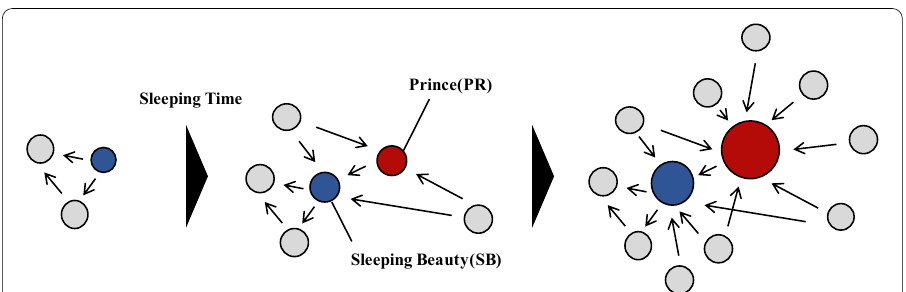
Fig. 1 Overview of how a PR discovers an SB in the citation network. Each node represents papers and edges shows their citation. (1, left) As soon as an SB is submitted, it is indistinguishable from ordinary papers in the community without being cited much. (2, middle) When the PR realised the importance of the SB and cited it, it spread to the rest of the scientific community and led to the paper being co-cited. (3, right) A sub-field created by a pair of papers becomes widely recognised, and a new field can emerge from